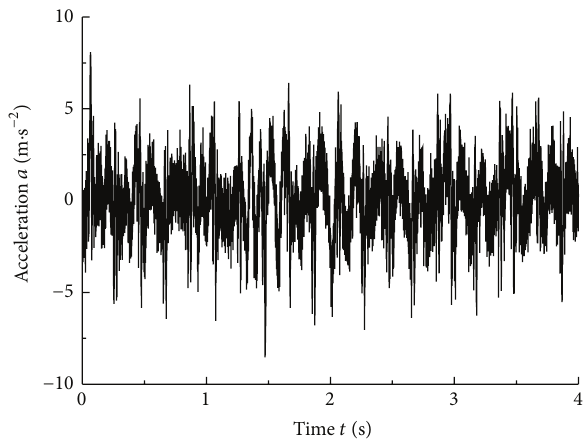
Figure 23: Vibration waveform of test rig experiment at the speed of 100